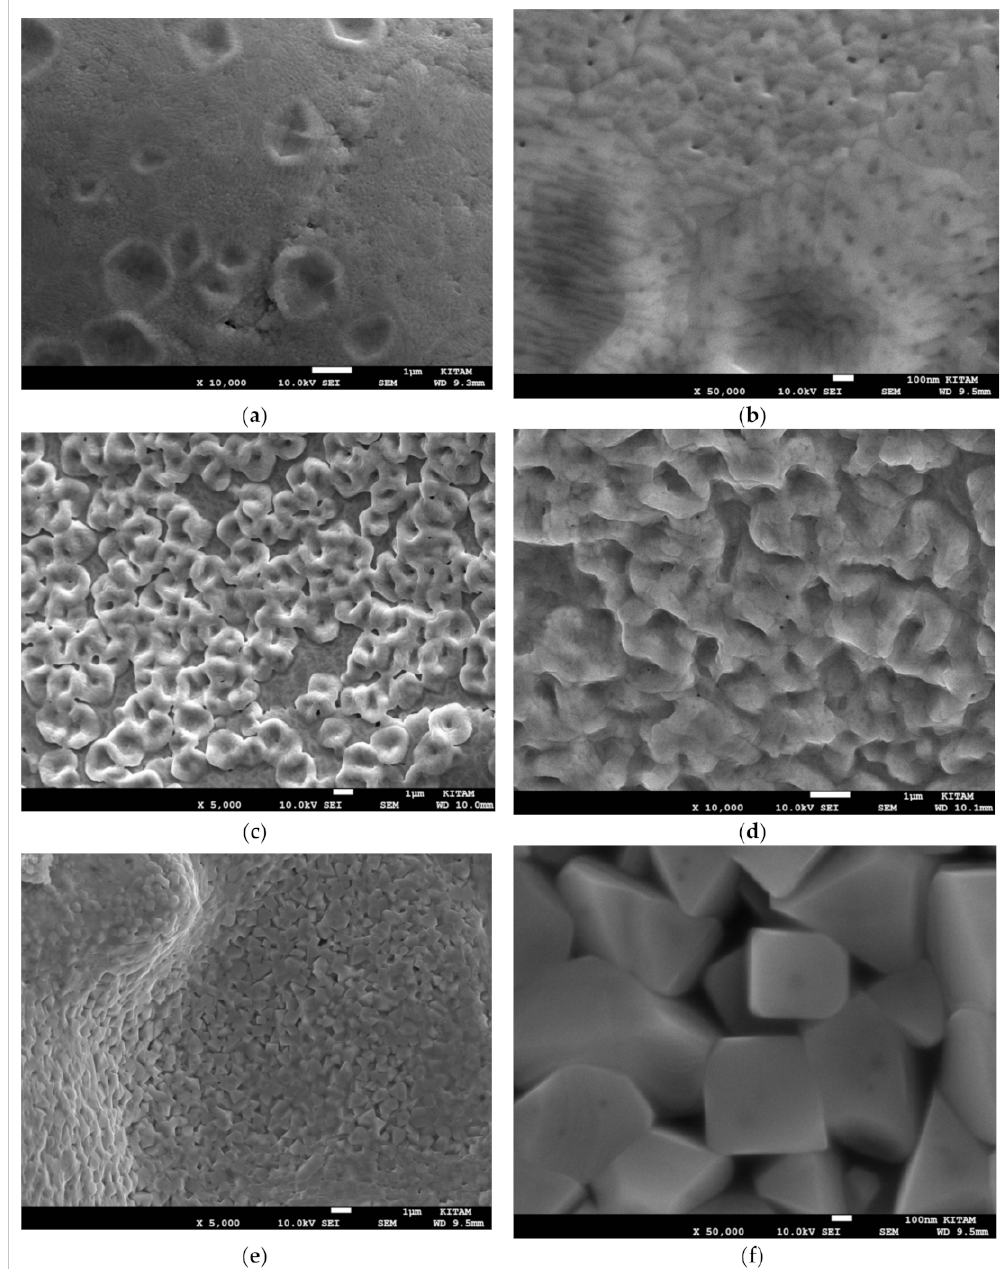
Figure 28. Surface morphology evaluation by SEM as a function of composition for Mn / Si = 2 catalyst synthesized at 1800 W for 60 s with plasma generation. ( a ) Low Mn region with: [Mn] = 0.201; [Si] = 0.115; [O] = 0.684; ( b ) Same as in ( a ) at higher magnification; ( c ) Average Mn region, with: [Mn] = 0.317; [Si] = 0.075; [O] = 0.608; ( d ) High Mn region with: [Mn] = 0.772; [Si] = 0.059; [O] = 0.169; ( e ) Pore surface when [Mn] = 0.843; [Si] = 0.023; [O] = 0.134; ( f ) Same as in ( a ) at higher magnification. Scale bar = 1 µ m ( a , c – e ) and Scale bar = 100 nm ( b , f